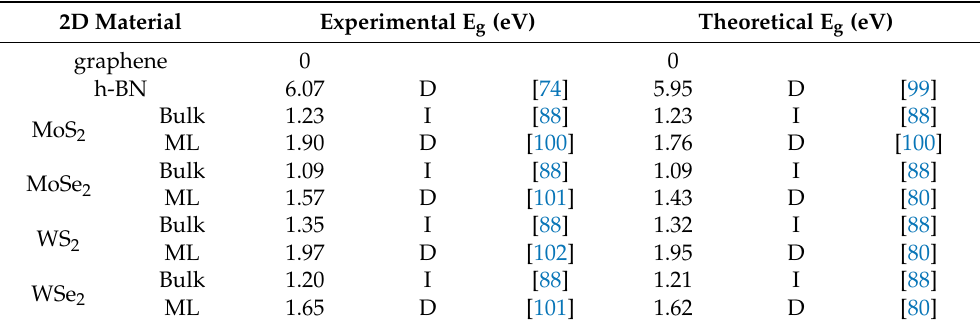
Table 2. Outline of the experimental and theoretical bandgaps of different 2D materials. D stands for direct and I stands for indirect band